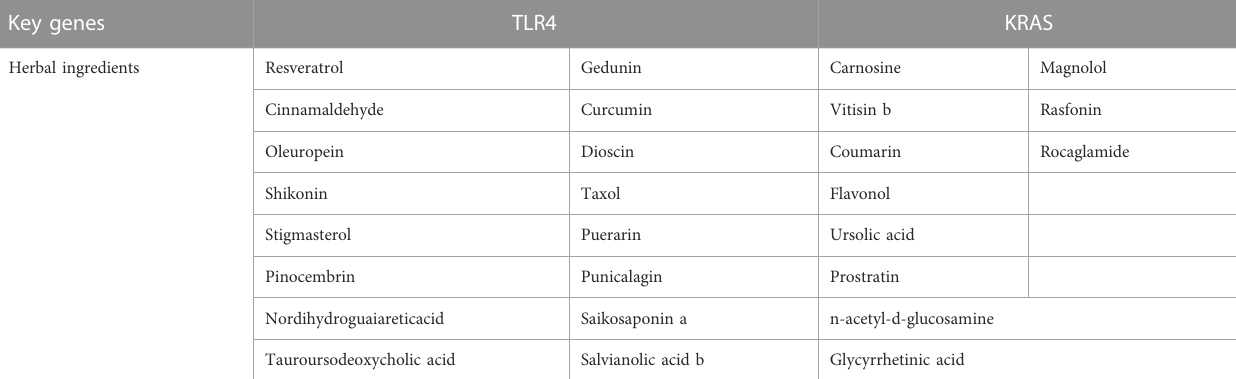
TABLE 3 Herbal ingredients predicted on the basis of key genes. Key genes Herbal ingredients